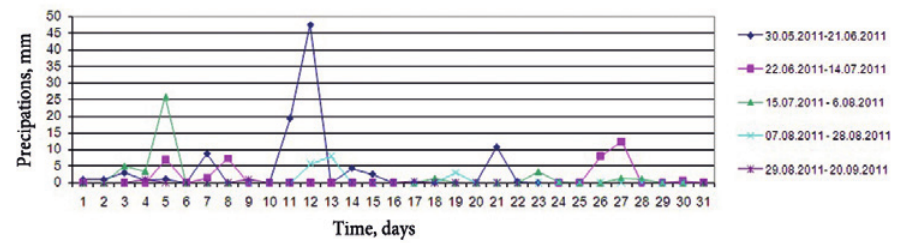
Fig. 5. Variation of precipitations along the duration of the phenological